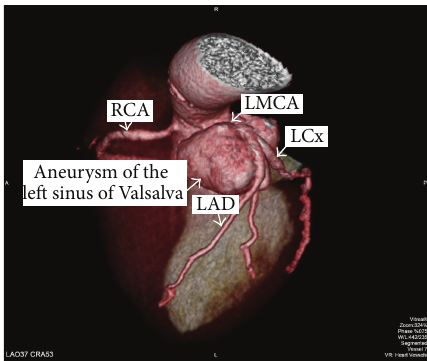
Figure 5: Post-PCI computed tomography angiography showing the giant aneurysm involving the three sinuses of Valsalva and its relationship with the major epicardial coronary arteries. PCI, percutaneous coronary intervention; RCA, right coronary artery; LMCA, left main coronary artery; LAD, left anterior descending; LCx, left